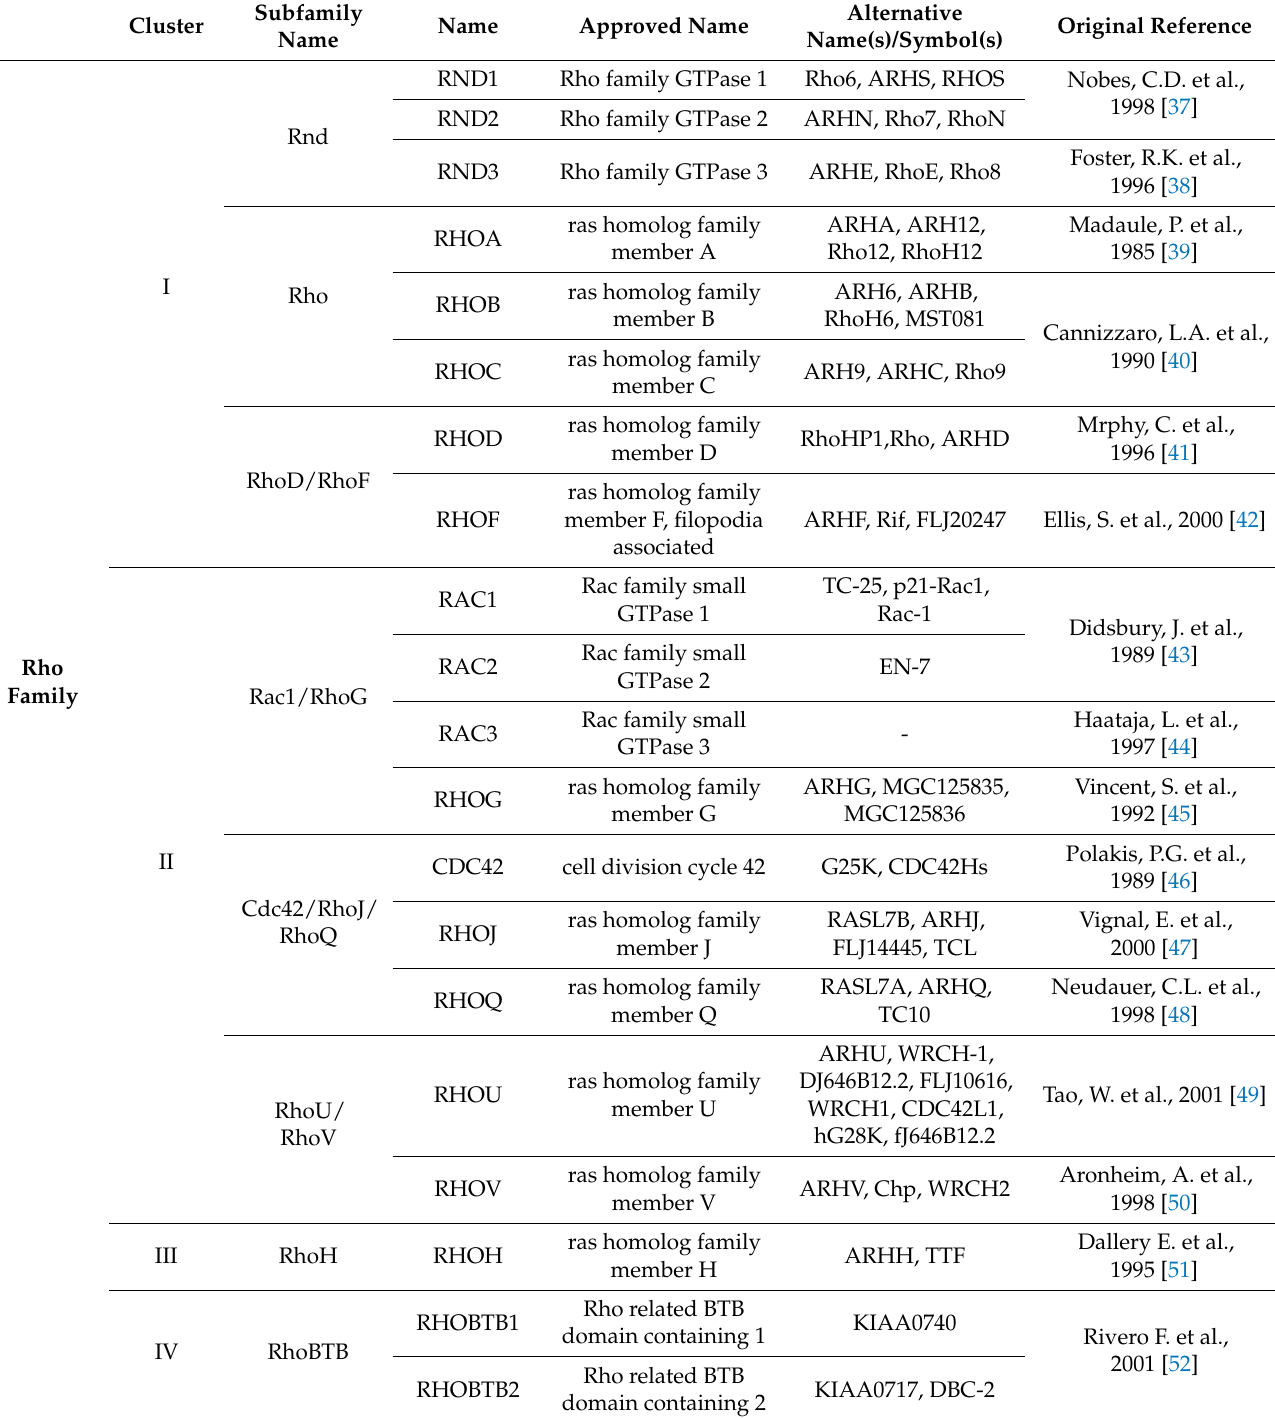
Table 1. Rho GTPase (Guanosine triphosphatase) family of proteins. Rho GTPases are members of the Ras superfamily of small GTPases. They are small molecular weight proteins that play critical roles in many cellular processes. The Rho family consists of 20 members, categorized in 4 clusters and 8 subfamilies. Previous common names and symbols are based on the HUGO gene nomenclature